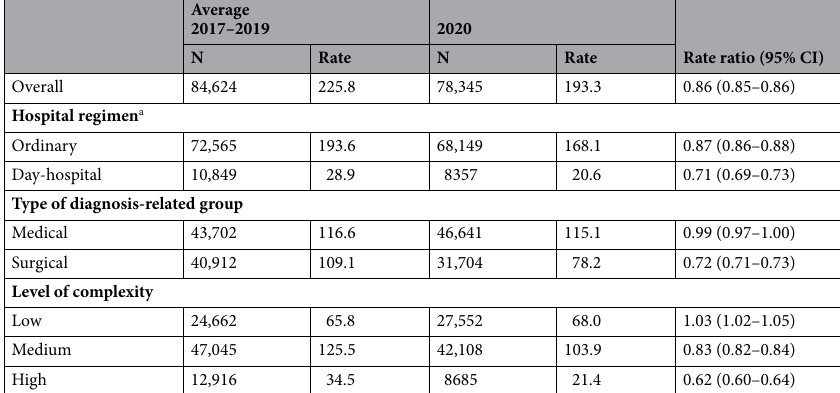
Table 2. Number of hospitalizations and corresponding rates (per 1000) among individuals aged 65 years or more with at least a chronic disease from ATS Brianza and ATS Bergamo combined, overall and by hospital regimen, type of hospitalization and level of complexity, in 2017–2019 and 2020, and rate ratio for 2020 versus 2017–2019, Lombardy, Italy. 95% CI 95% confidence interval. a This category does not include sub-acute hospitalizations, included in overall hospitalizations.